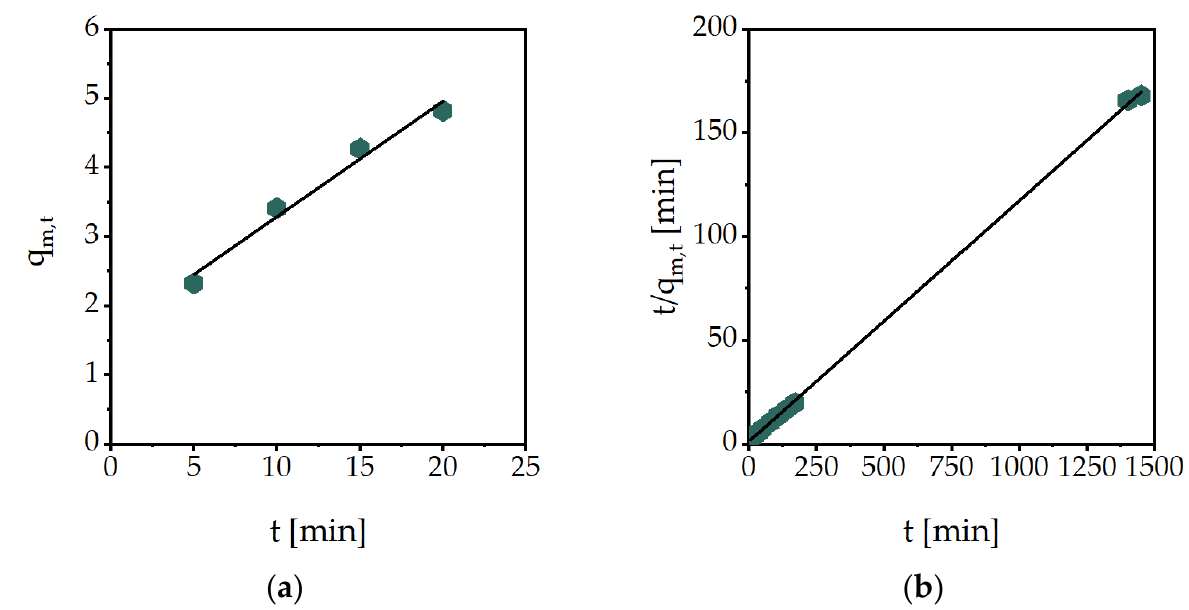
Figure 2. Diagrams used for further calculations exemplary for the swelling experiment of MASO 3 (2 mol/L) and MBAA (2 mol%) as a crosslinker. Linear fits to obtain ( a ) the initial swelling rate and ( b ) the swelling rate constant k S . Table 1. Summary of the calculated swelling kinetic values of different hydrogels.